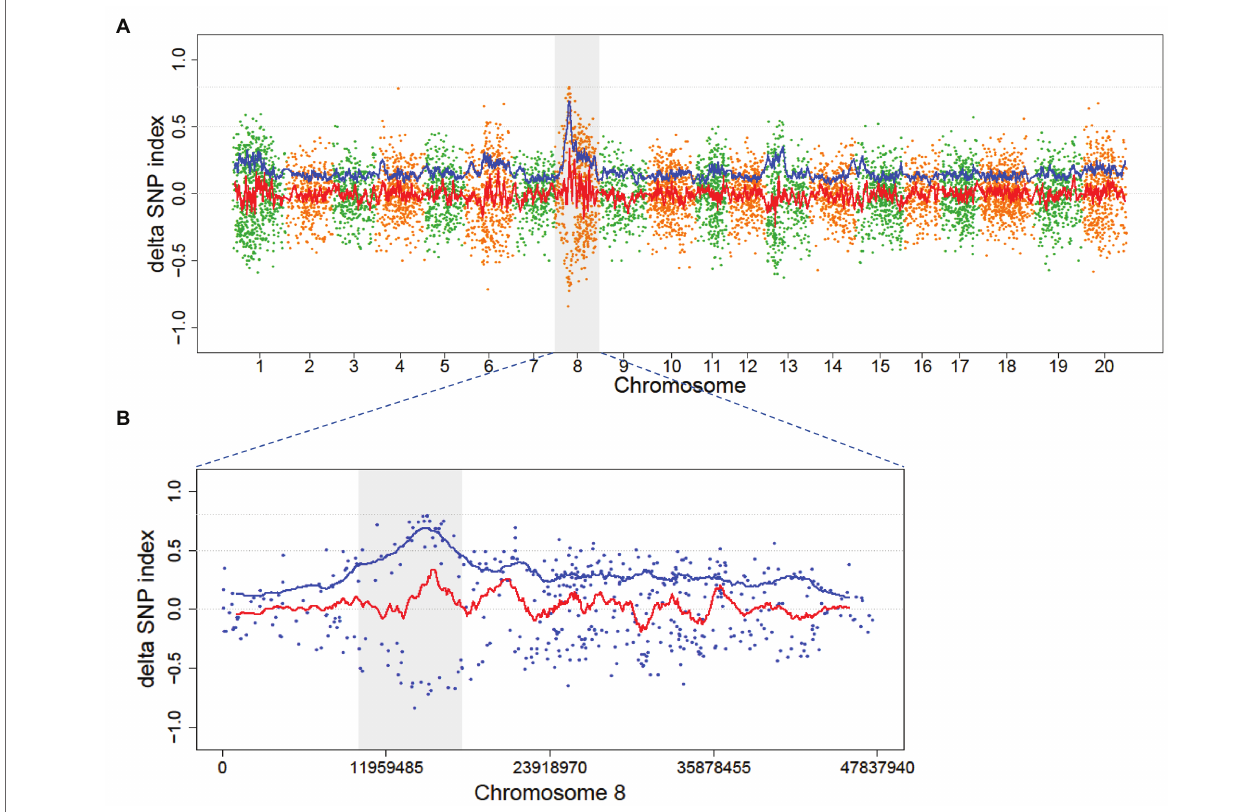
FIGURE 4 | Distribution of ADSI in the M 2 of Mut01 population at the whole-genome level and causal region in Chromosome 8. Each point represents a SNVs, the red line is the fitted curve of DSI, and the blue line is the fitted curve of ADSI. (A) Whole-genome plot, Chromosome 8 is highlighted with gray color. (B) Partial enlarged view of Chromosome 8, the candidate region (10–18 Mb) is highlighted with gray color, the peak of blue line indicates the candidate region with a causal